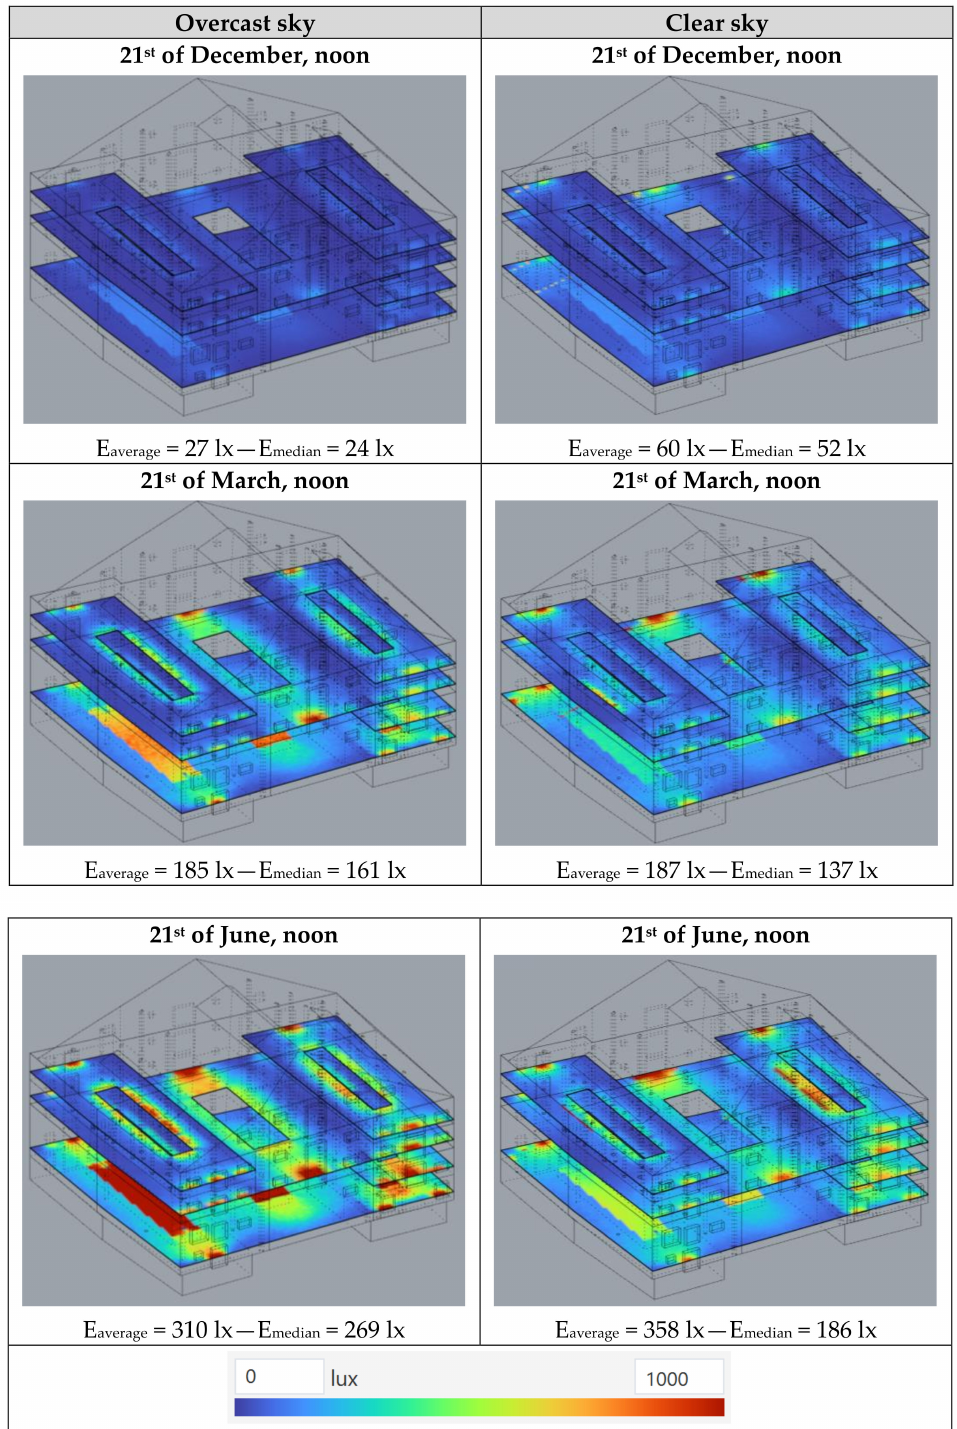
Figure 14. Point-in-time illuminances inside the building for the optimized atrium